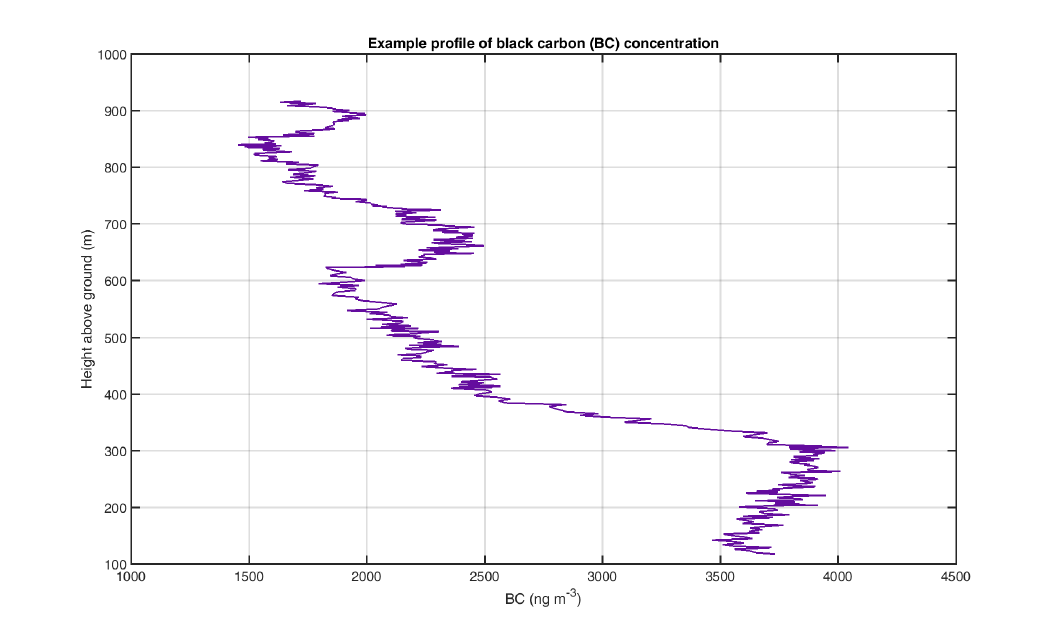
Figure 12. An example of a retrieved vertical profile of BC (black carbon) mass concentration, measured on 15 July, at 06:30 UTC in Savè (Collines, Benin) during the DACCIWA [27] project. An enhanced BC concentration was observed in the lowermost 400m that was affected by the existence of a nocturnal low-level